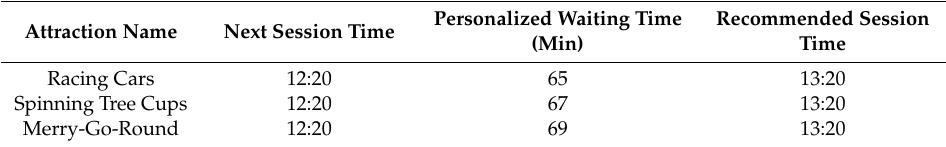
Table 2. Calculation results for the Shortest Waiting Time First strategy.